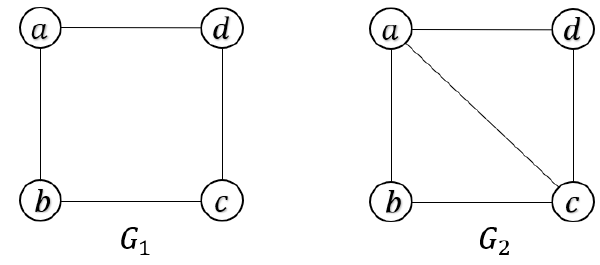
Figure 1. G 1 is a prime graph and G 2 is a reducible graph.